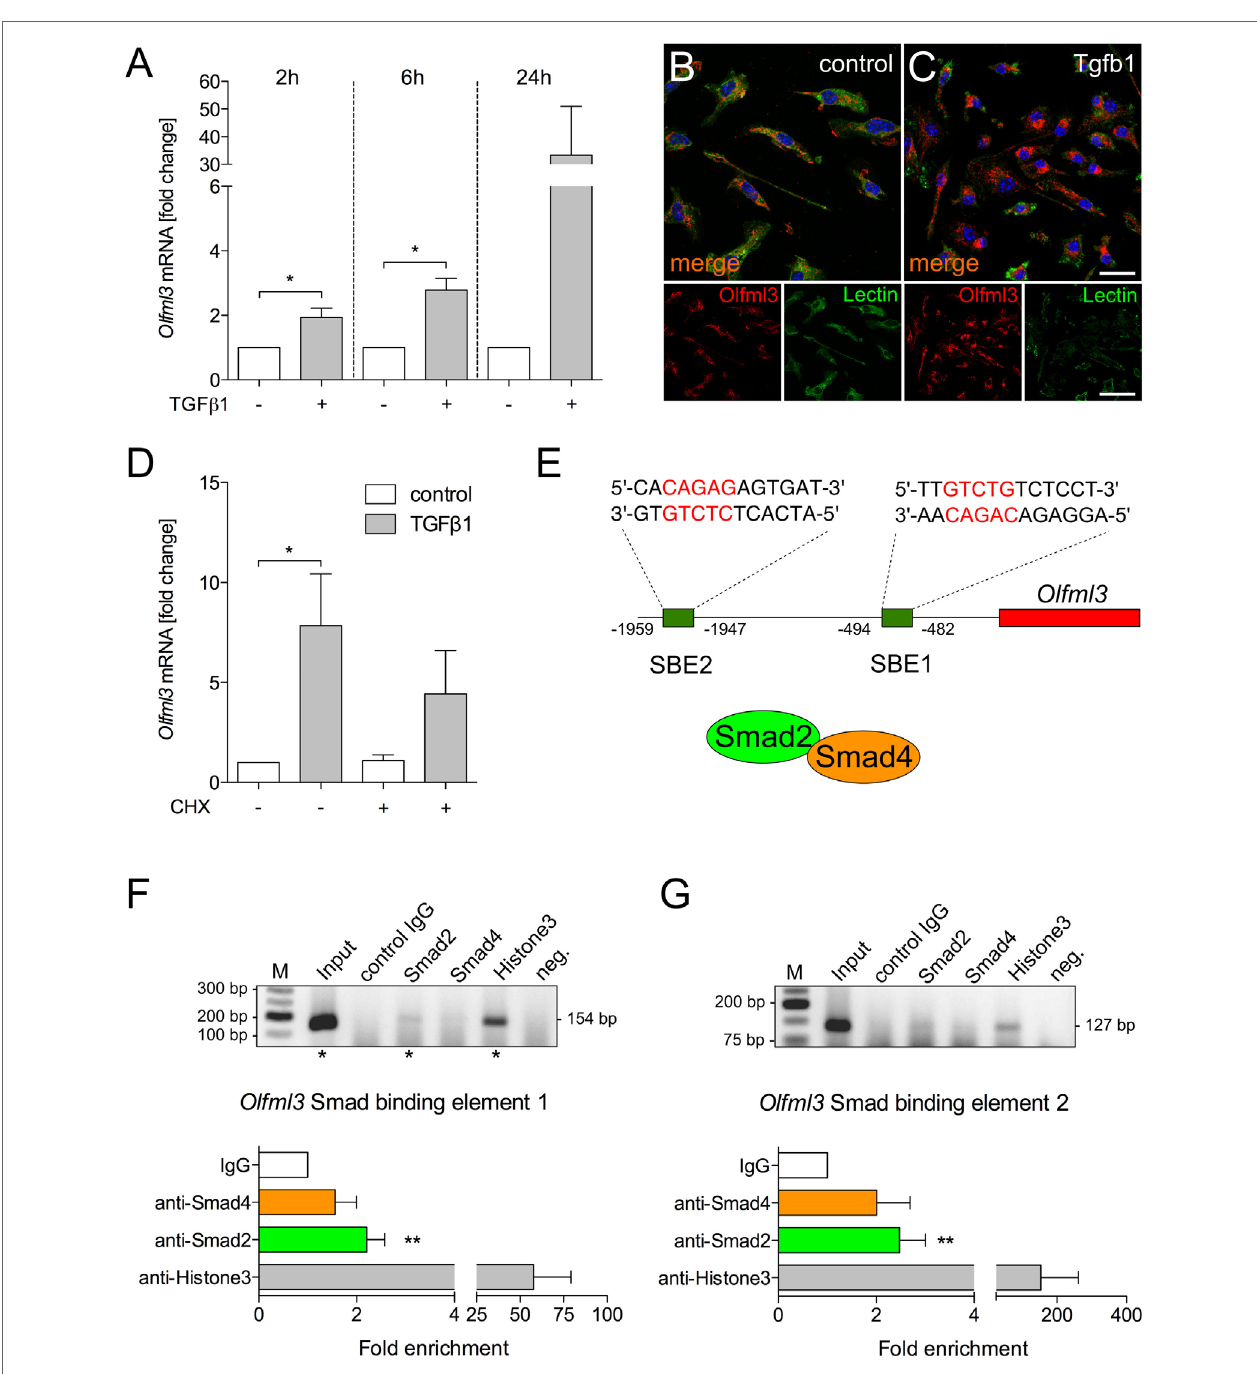
FigUre 4 | Identification of Olfml3 as a direct transforming growth factor β 1 (TGF β 1)/Smad2 target gene (a) Increased expression of Olfml3 in primary microglia treated with recombinant TGF β 1 (5 ng/ml) for indicated time points. Immunocytochemistry demonstrating expression of Olfml3 in control (B) and TGF treated primary microglia (c) after 24 h. FITC-coupled tomatolectin was used to label microglia. Scale bars represent 10 µm for merged images and 20 µm for single stain images. (D) Cycloheximide-induced inhibition of protein synthesis only marginally affected TGF β 1-induced expression of Olfml3 in primary microglia. (e) Genomic organization of Olfml3 displaying localization and sequence of in silico -predicted Smad-binding elements (SBEs). Results of chromatin immunoprecipitation (ChIP) PCR amplification and quantifications of qPCR results after ChIP of TGF β 1-treated BV2 microglia using Smad4- and Smad2-specific antibodies. Significant enrichment after Smad2 precipitation was detected for SBE1 (F) as well as for SBE2 (g) . Asterisks mark Olfml3 promoter PCR product separated by agarose gel electrophoresis (F,g) . Smad4 binding could not be observed for all SBEs. Anti-Histone3 antibodies were used as a positive control and non-specific isotype IgGs were used as a negative control for all ChIP experiments. Data are presented as mean ± SEM from at least three independent experiments. P -values derived from Student’s t -test are * P < 0.05 (a,F,g) . P -values derived from one-way ANOVA are * P < 0.05 (D)